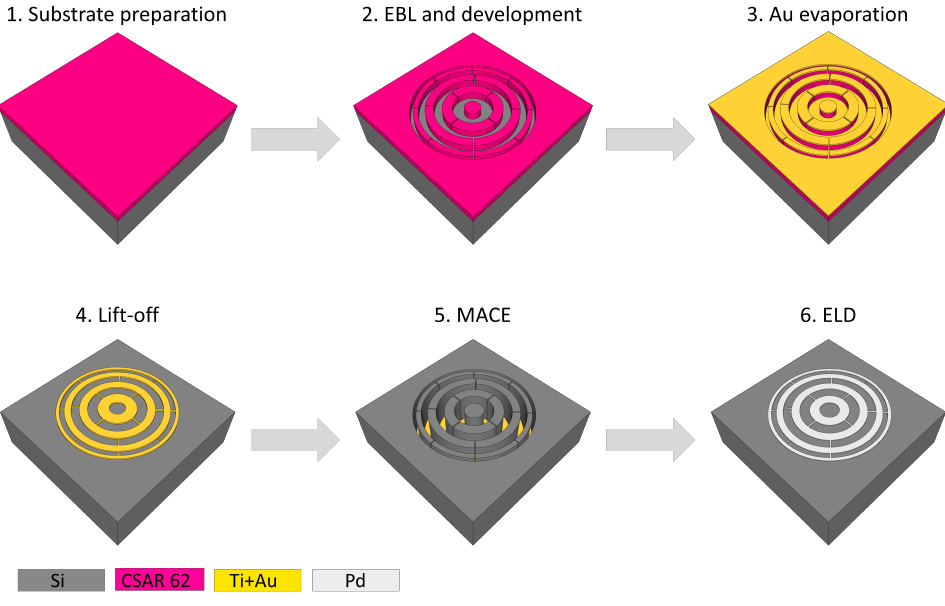
Figure 1. Schematic of the zone plate fabrication